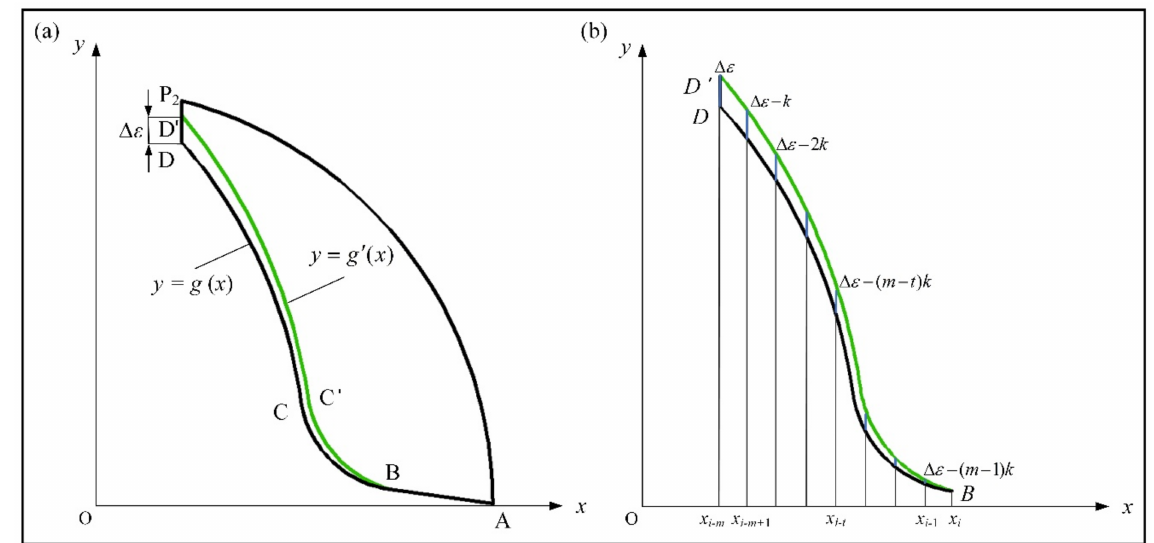
Figure 6. Optimization for variable-pitch end mill: ( a ) groove morphology; ( b ) comparison before and after